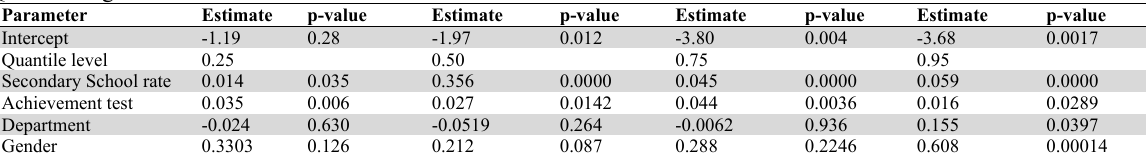
Quantile Regression Model